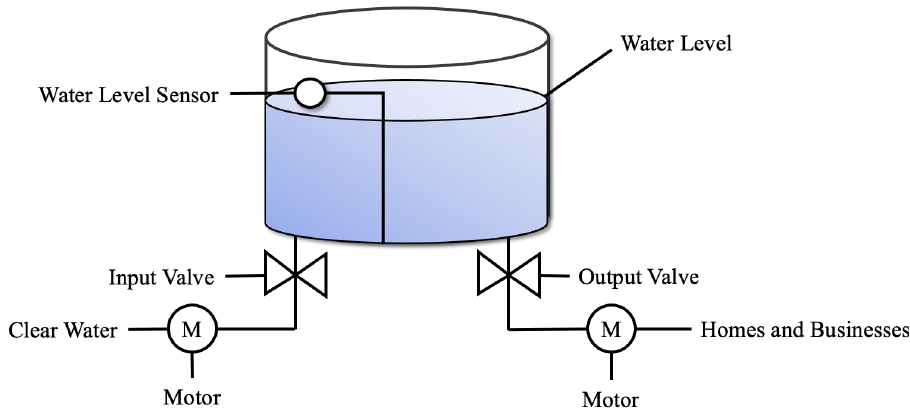
Figure 11. The Process of Water Storage.